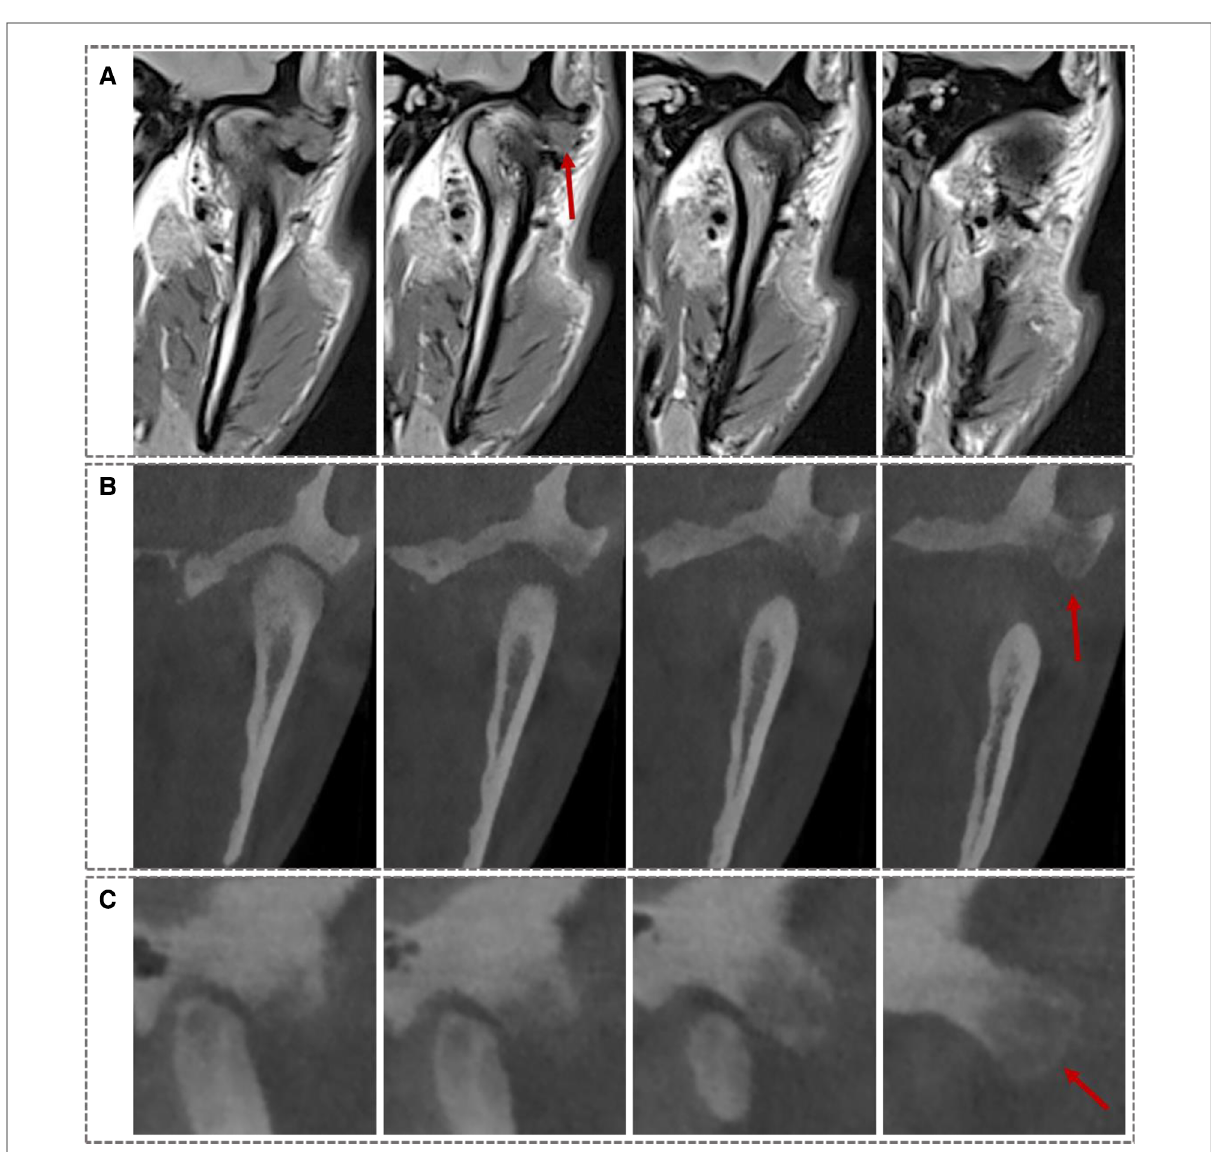
FIGURE 1 Preoperative MRI and CT images: (A) coronal MRI images showed a mass at the left articular tubercle. (B) Coronal CT images showed a heterogeneous mass at the left articular tubercle. (C) Sagittal CT images showed the same. (Red arrows indicates the